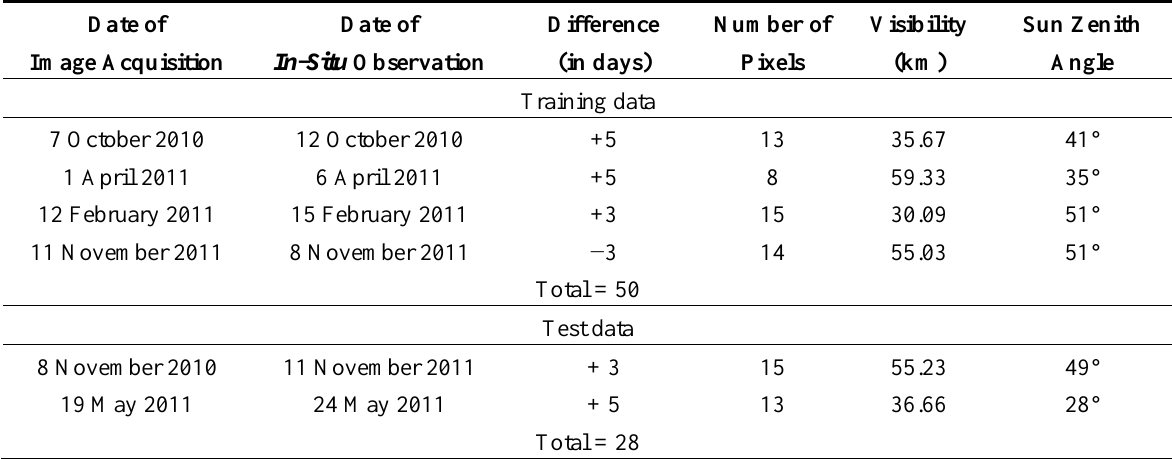
Table 1. Information related to six Landsat-5 TM images obtained under clear sky